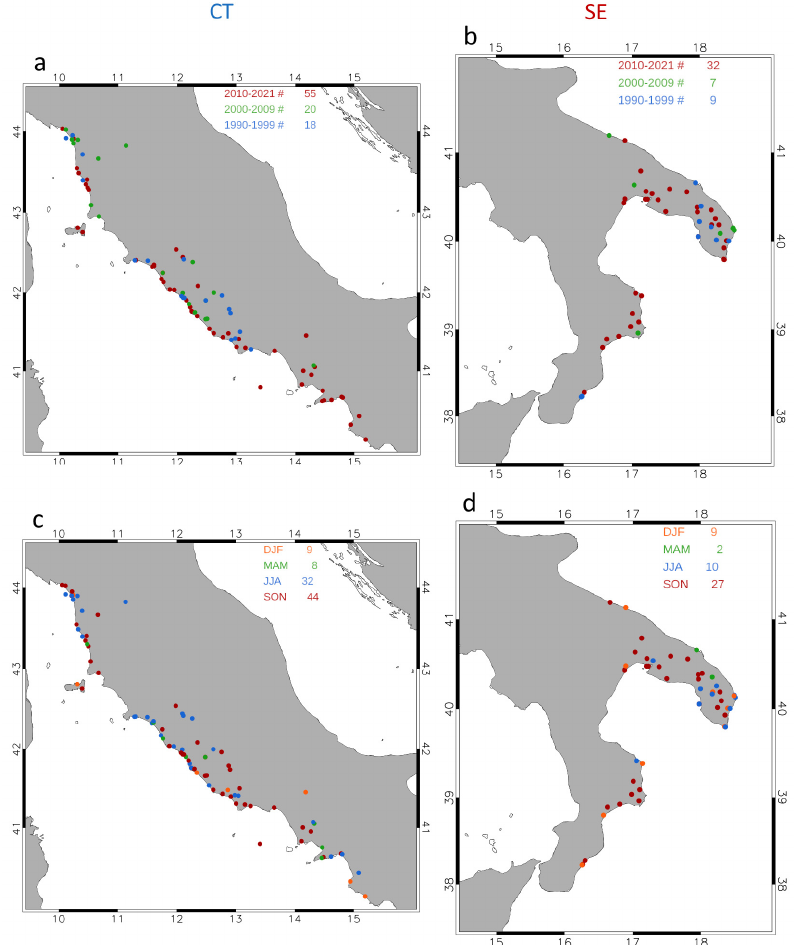
Figure 2. Position of the 93 (CT regions; ( a , c )) and 48 (SE regions; ( b , d )) tornadoes during the 32-year period. On the top right, the different colors in ( a , b ) refer to the different last decades, while in ( c , d ) they refer to the seasons: DJF (December, January, February), MAM (March, April, May), JJA (June, July, August), SON (September, October,